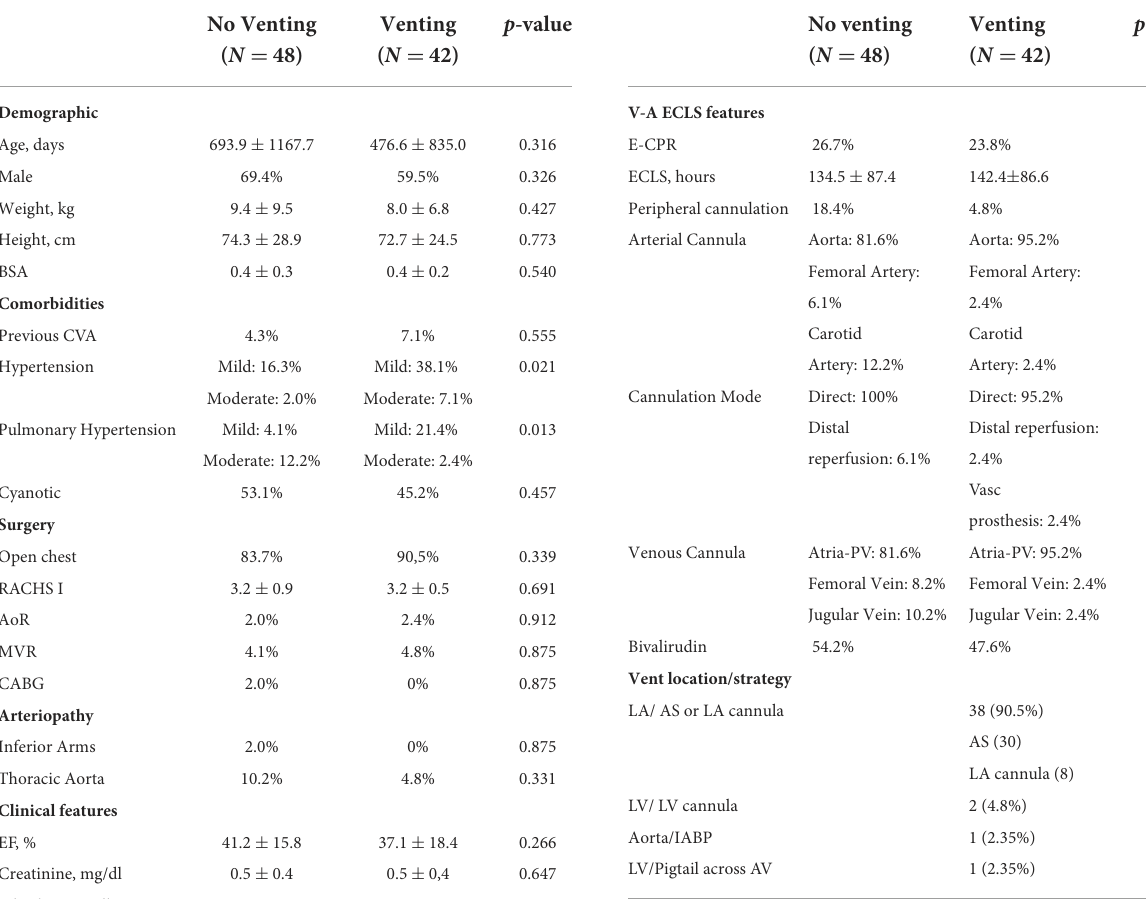
TABLE 2 Demographic and clinical features. TABLE 3 V-A ECLS and LV Unloading